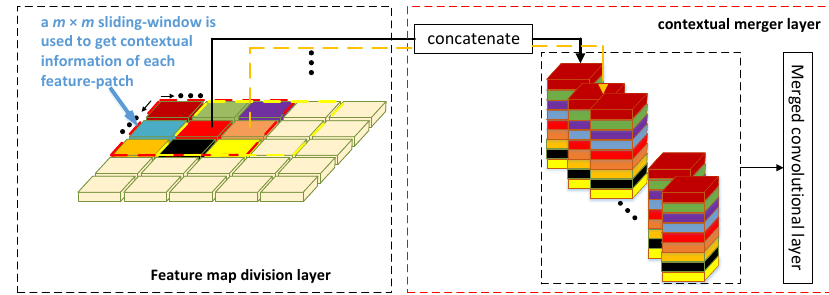
Feature map division layer Figure 3. General concept of the proposed CBAF